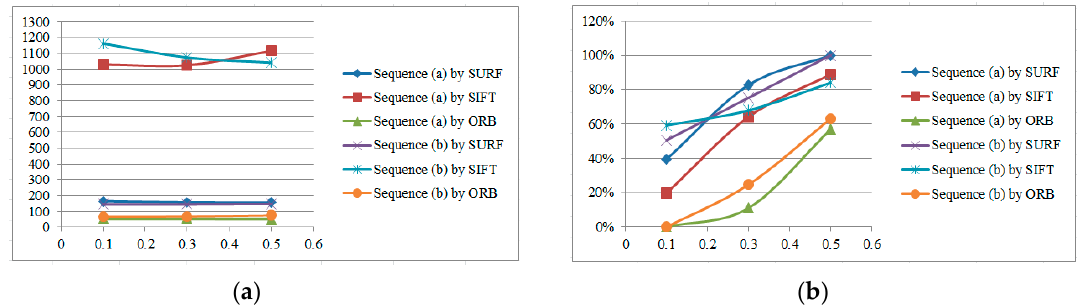
Figure 8. Images in two sample sequences with feature points placed on them.